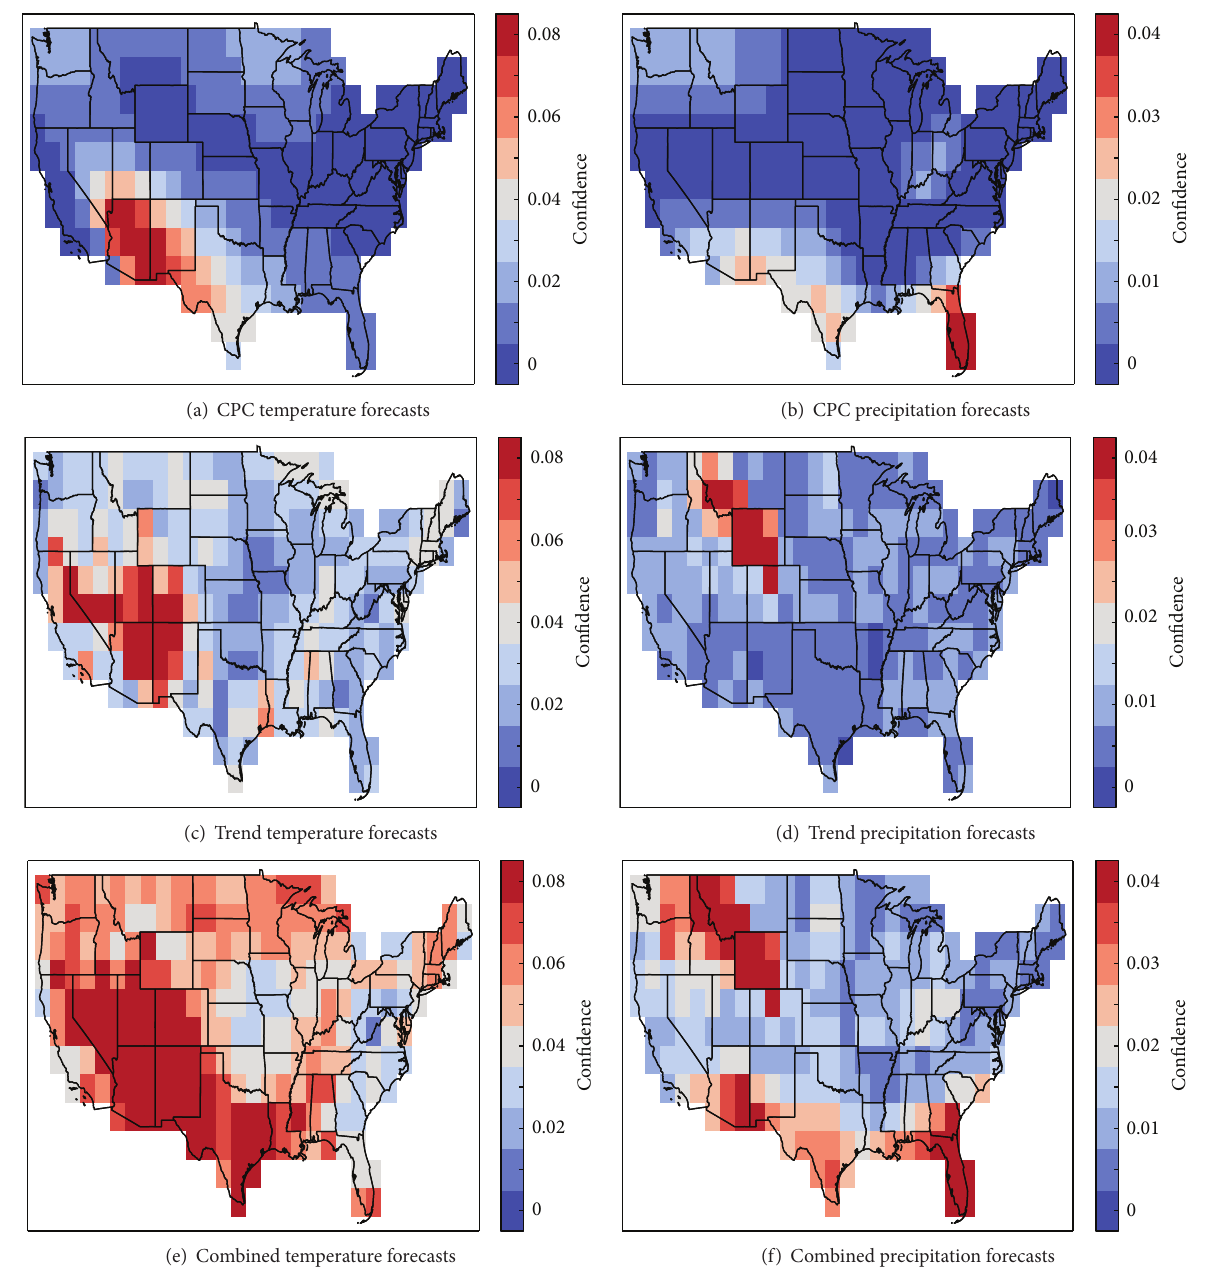
(f) Combined precipitation forecasts